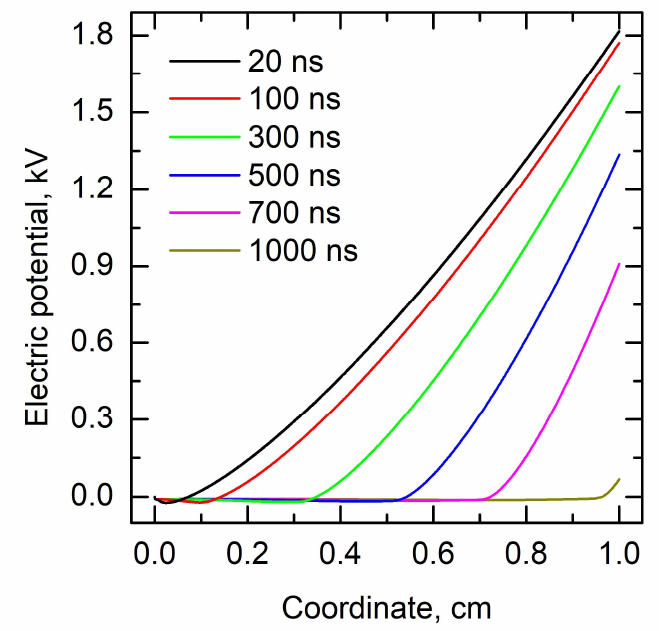
Figure 3. Spatial distribution of the electrostatic potential in vacuum diode with antimony cathode given for selected time steps.